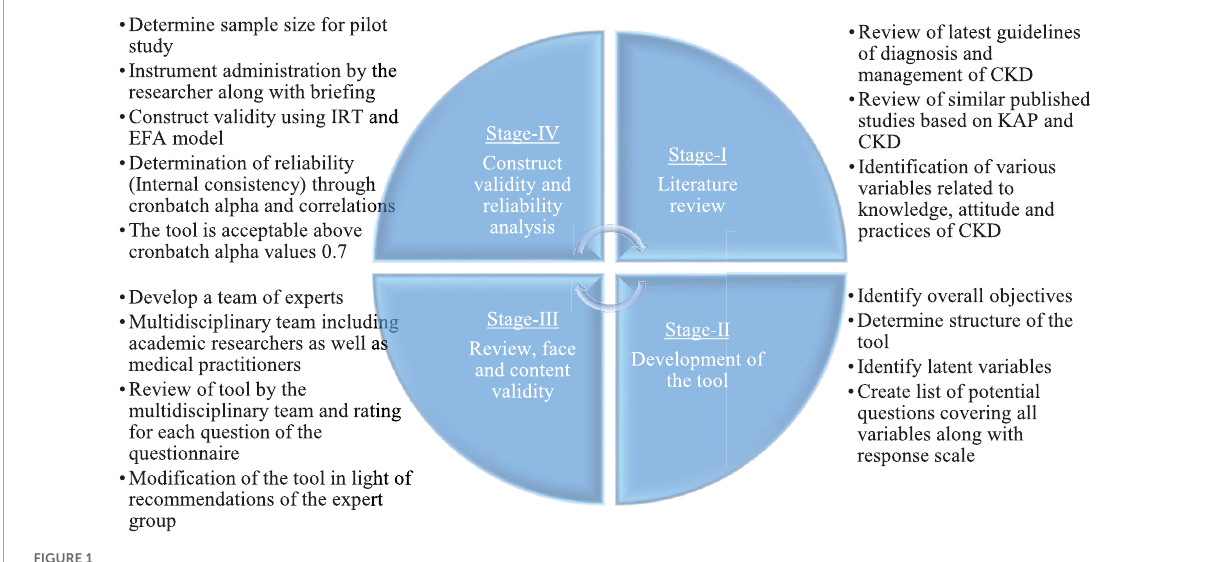
FIGURE1 Process of development and validation of CKD-KAP questionnaire.